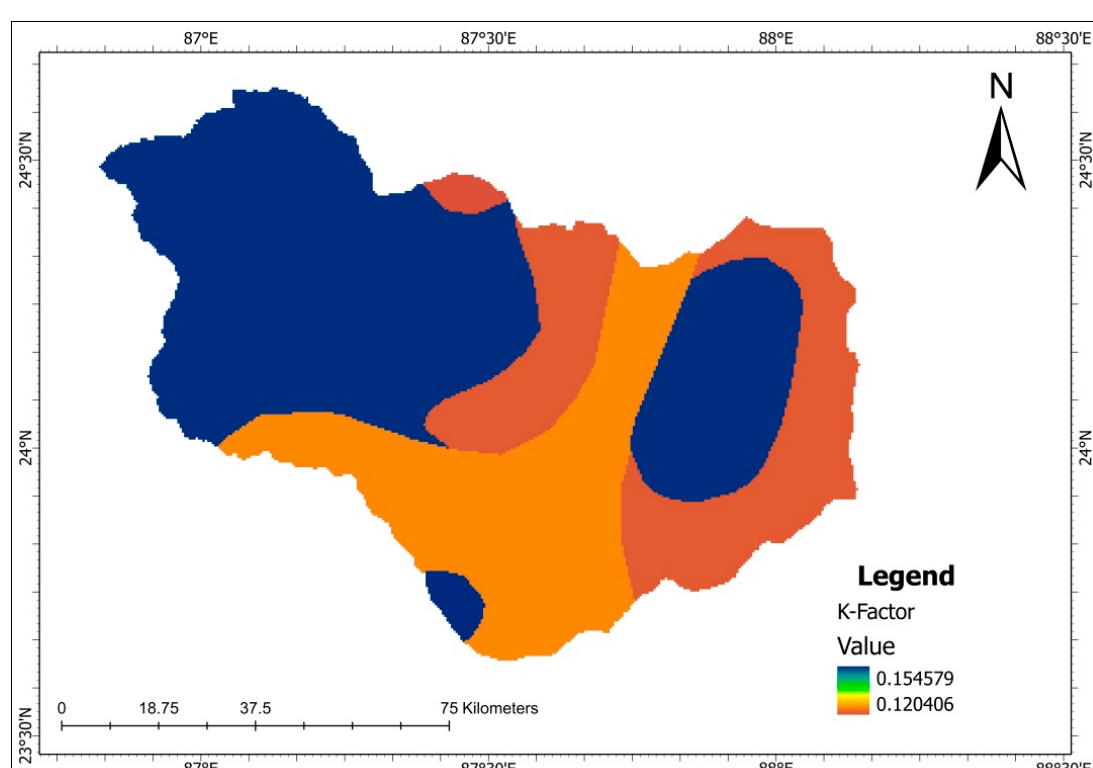
Figure 7. Soil erodibility factor (K) map.